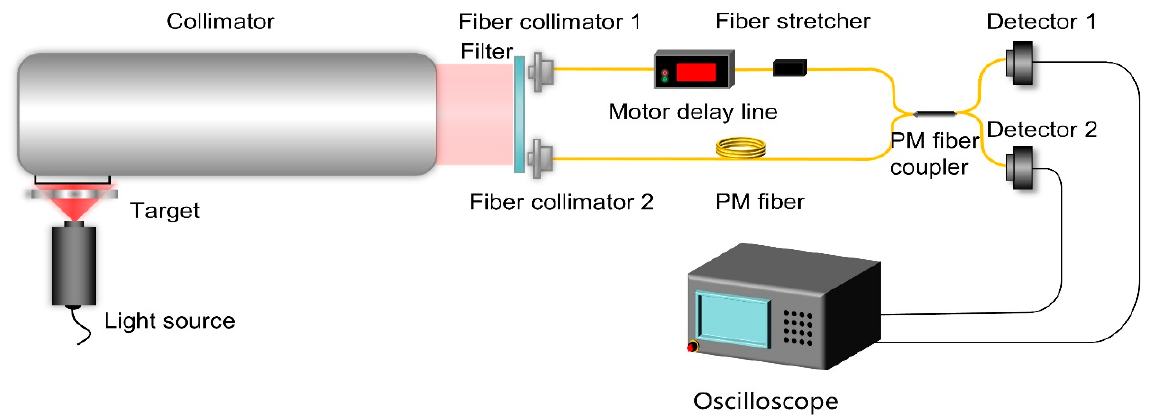
Figure 13. Layout of the experimental setup for wavefront-division interference.